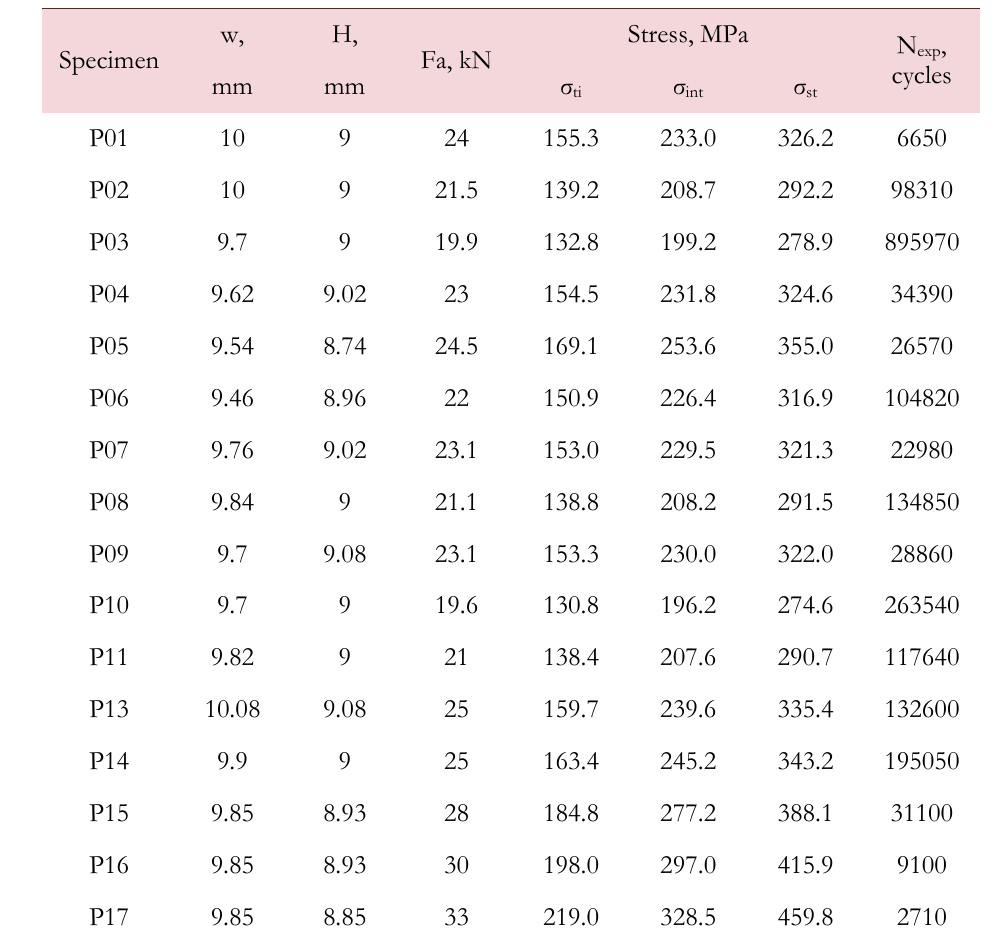
Table 3: Results of the fatigue tests.